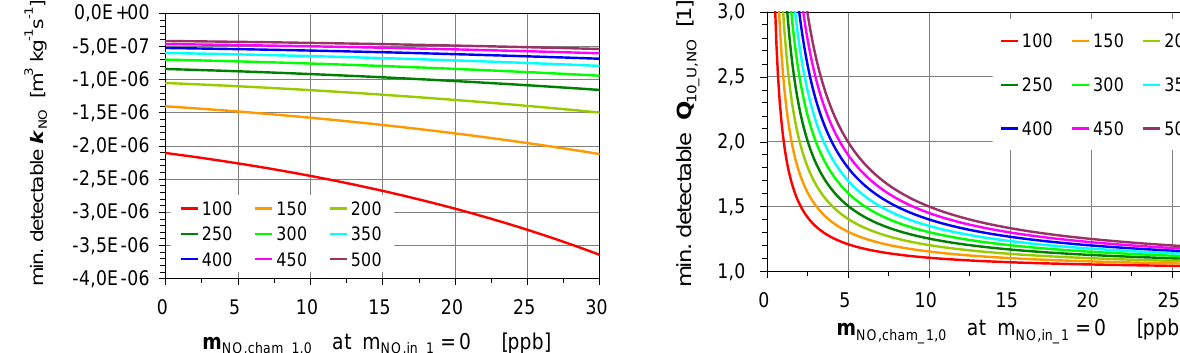
Figure 17. Minimum detectable NO consumption coefficient (at θ 0 and T 0 ) as function of the NO mixing ratio in the soil chamber’s Fig. 17: Minimum detectable NO consumption coefficient (at  0 and T 0 ) as function of headspace ( θ g = θ 0 ; m NO , in_1 / 3 = 0). Data have been calculated the NO mixing ratio in the soil chamber’s headspace (  g =  0 ; m NO,in_1/3 = 0). for m soil , dry = 0.06kg and LOD NO = 0.15ppb on the basis of the Data have been calculated for m soil,dry = 0.06 kg and LOD NO = 0.15 ppb on the NO x -analyser’s precision. Colour code indicates different NO com- basis of the NO x -analyzer’s precision. Color code indicates different NO com- pensation point mixing ratios, m NO , comp . pensation point mixing ratios, m NO,comp .